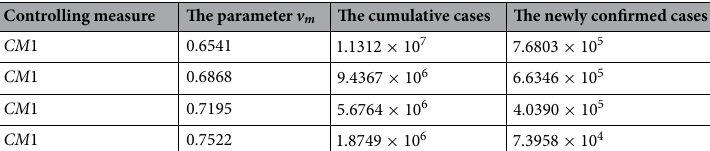
Table 9. The effect of the CM 1 on the cumulative